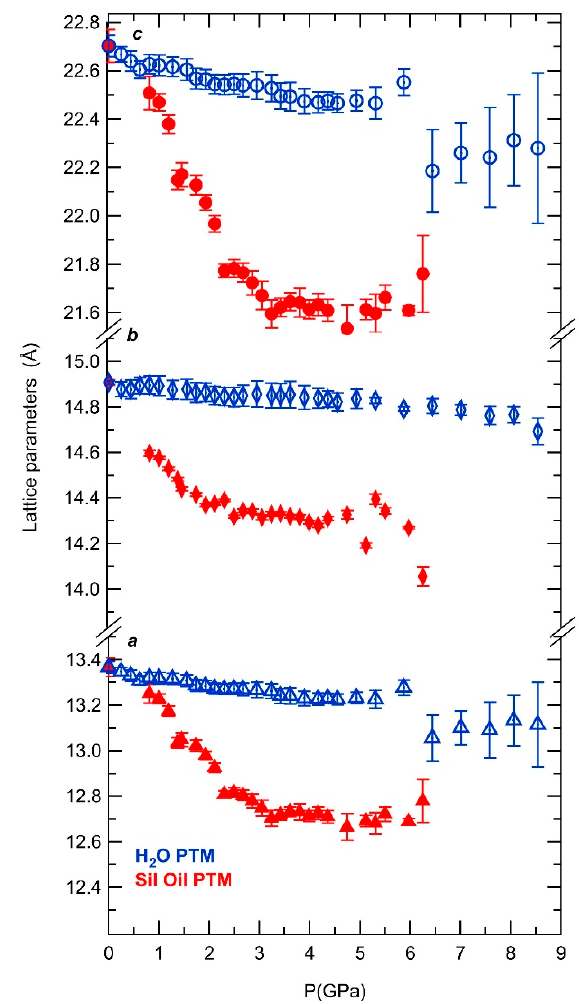
Figure 3. Lattice parameters as a function of pressure in silicone oil (red) and in H 2 O (blue) PTM.